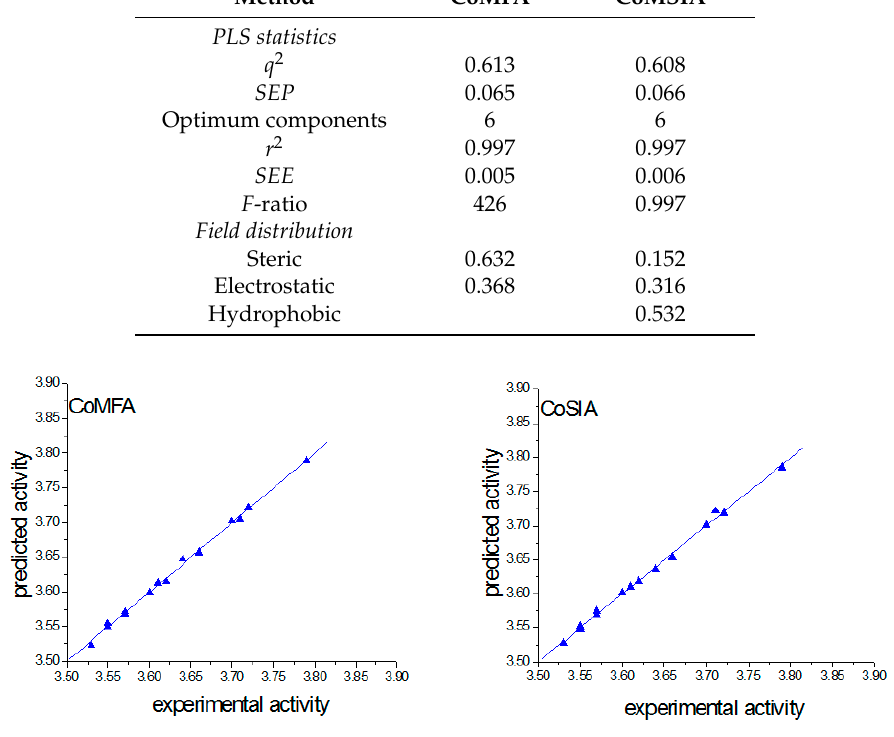
Figure 3. Plot of experimental against predicted pIC 50 by CoMFA and CoMSIA.